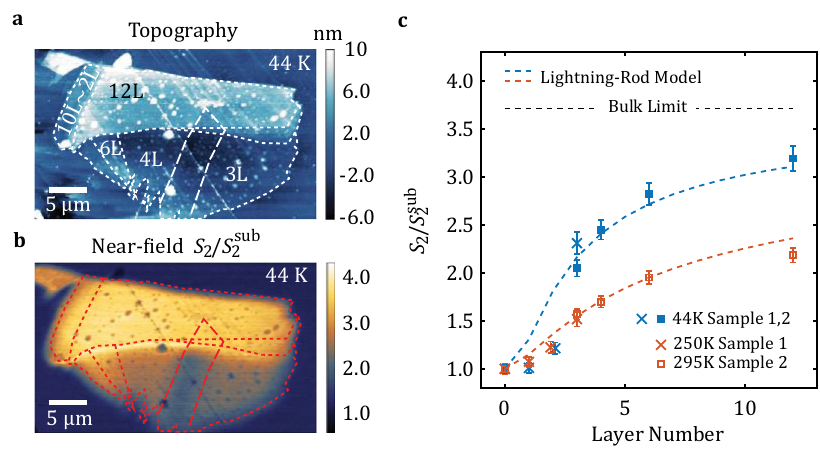
Fig. 5 Layer-dependent WL near- fi eld signal on WTe 2 . a Topography image of the sample at 44 K. The boundaries of different regions are highlighted with dashed lines. b Normalized WL signal S 2 = S sub imaged simultaneously with the topography. c Layer-dependent near- fi eld signal on few-layer WTe 2 . 2 The experiment data are collected on two different samples. The data points extracted from Fig. 2 (sample 1) are marked with crosses. The data points acquired on sample 2 are marked with squares. 3L WTe 2 is measured on both samples. High and low temperature data are displayed in red and blue points. The error-bars are the standard deviations of the extracted data in Figs. 2b and 5b. The dashed lines are LRM near- fi eld signal contributed by thermally activated carriers with a gap size ~ − 20 meV at 44 K (blue) and 295 K (3 : 6 e 12 cm (cid:3) 2 ) estimated in the ARPES experiment 12 . The higher than bilayer with the same gap size. In the right panel of temperature dependences of the scattering rate and of the carrier Fig. 4c, the simulated temperature dependence of the WL signal density dictate the temperature dependence of the near- fi eld on trilayer WTe 2 with Δ ¼ (cid:3) 20 meV (red curve) almost perfectly response. As is shown in Fig. 4b, thermally activated carriers fi directly contribute to the signal measured in our experiment.